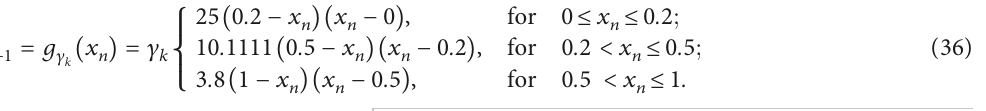
( x ) ; (b) g ( x ) ; and c 1 � 0 . 8 n c 2 � 2 n